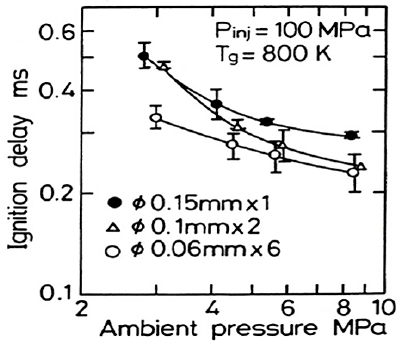
Figure 29. Effect of nozzle diameter on ignition delay [37].